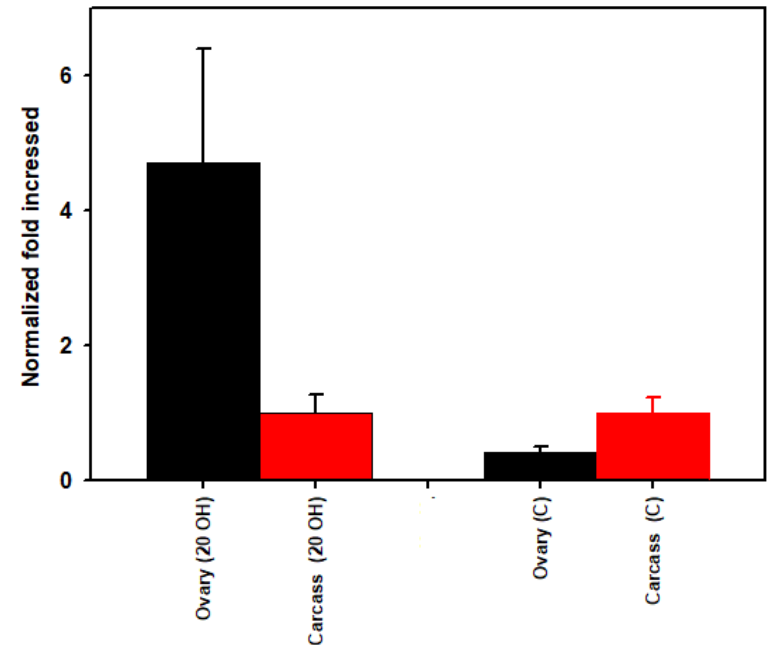
Figure 4. Rickettsia spp. load (qPCR using the 23S-5S gene target) in part-fed (virgin) Dermacentor variabilis ovaries versus carcass for 20-hydroxyecdysone (20E) versus buffer (C) injected ticks. Mean fold change ± SEM.